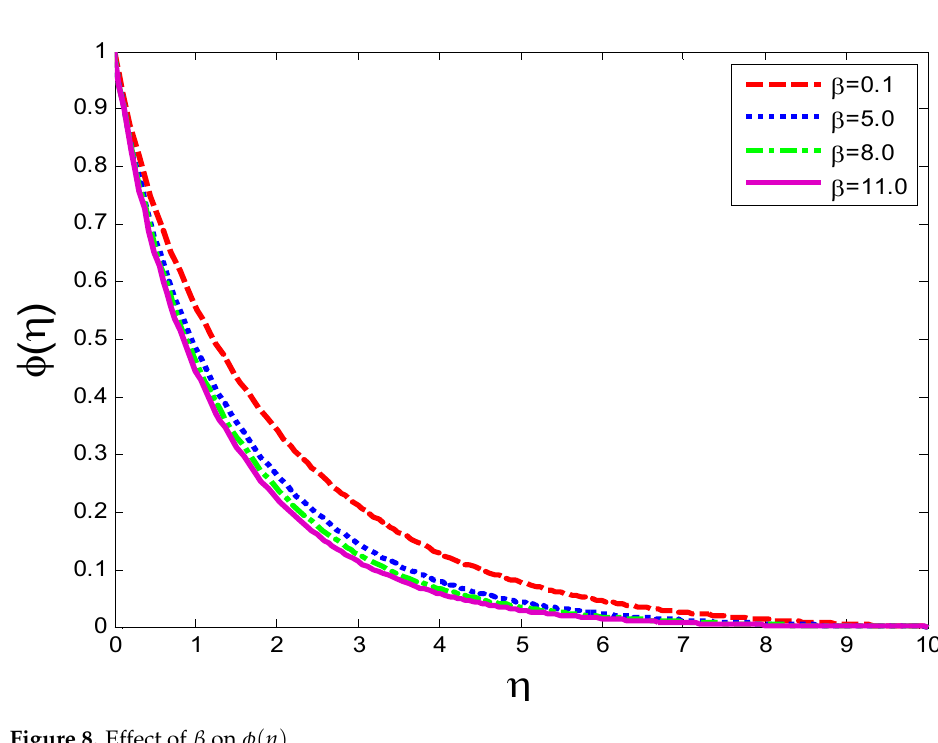
Figure 8. Effect of β on φ ( η )